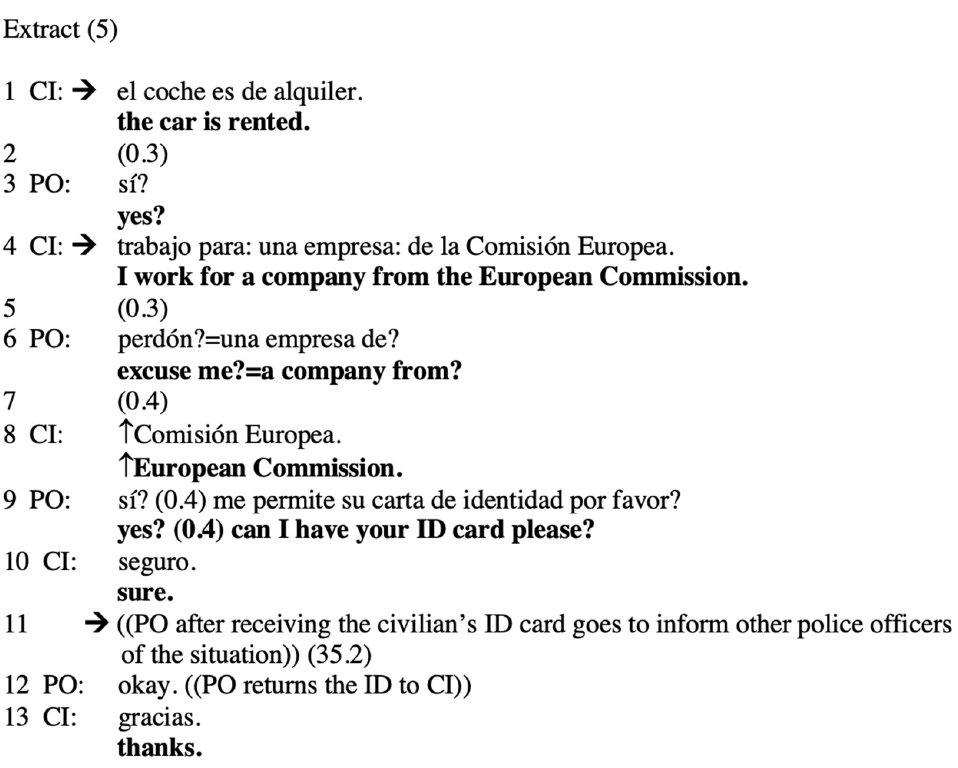
Figure 8. Extract (5).